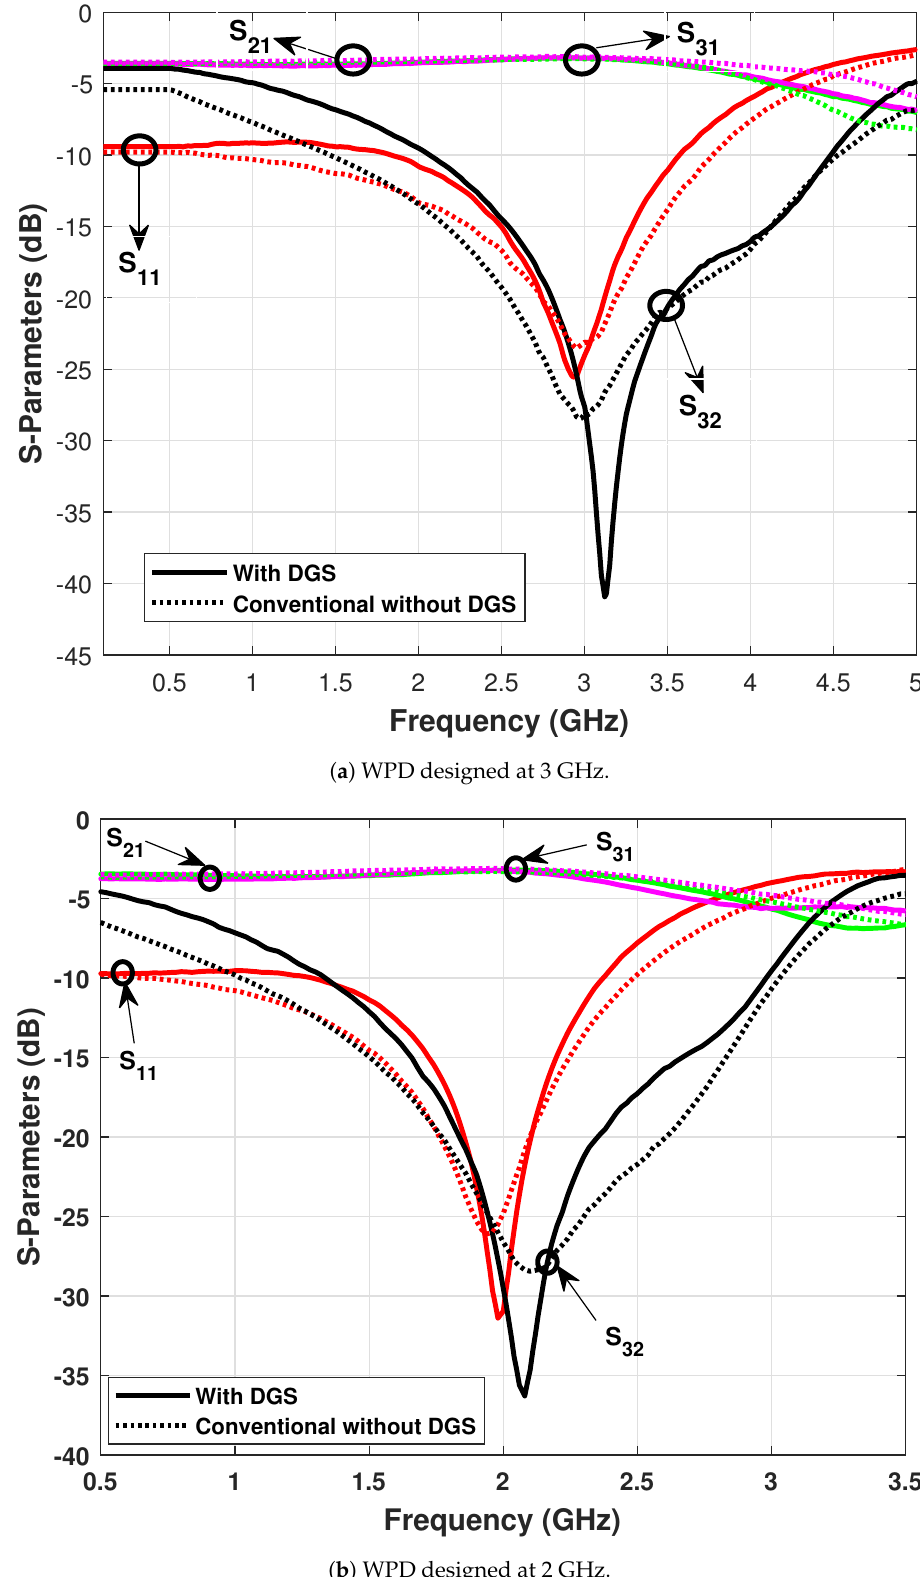
Figure 15. MeasuredS–parameters results of the fabricated conventional WPDs and the proposed WPDs with